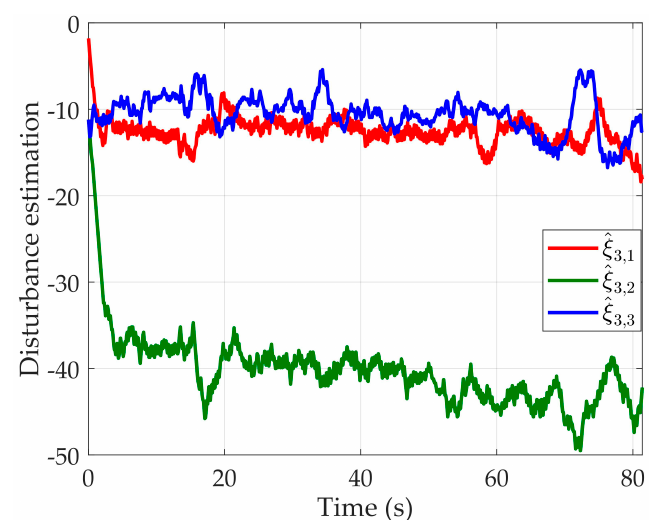
Figure 23 . Curves of disturbance estimation. Figure 23. Curves of disturbance